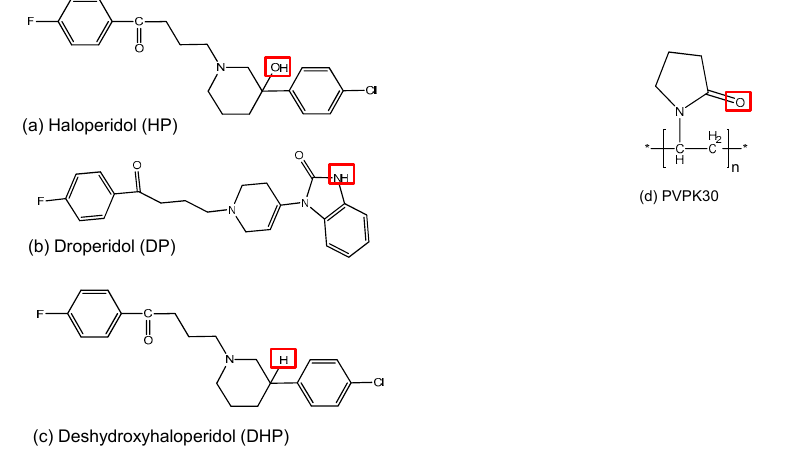
Figure 1. Structure of three model drugs ( a – c ) and the polymer ( d ) used in the study marking the hydrogen bonding donor and acceptor groups.